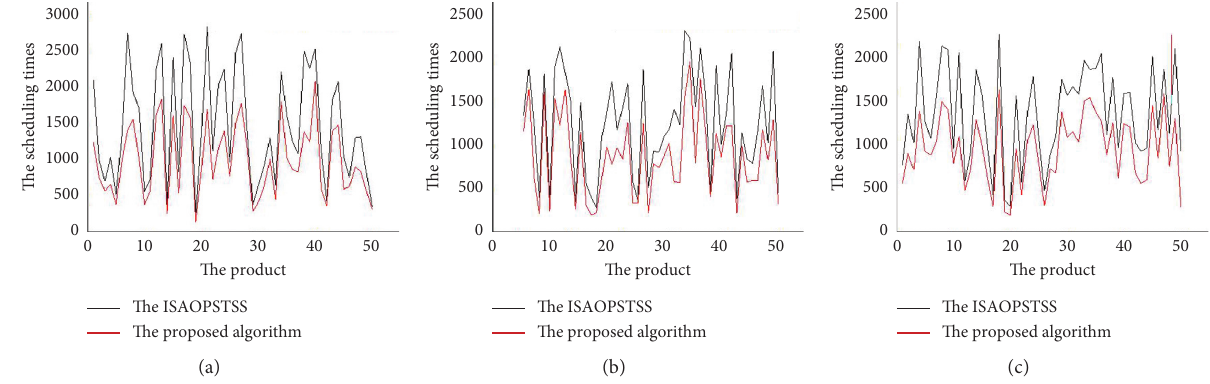
Figure 7: Comparison of scheduling times when the total number of processes is 80. (a) The scheduling times of 80 processes in 3 devices. (b) The scheduling times of 80 processes in 6 devices. (c) The scheduling times of 80 processes in 9 devices.